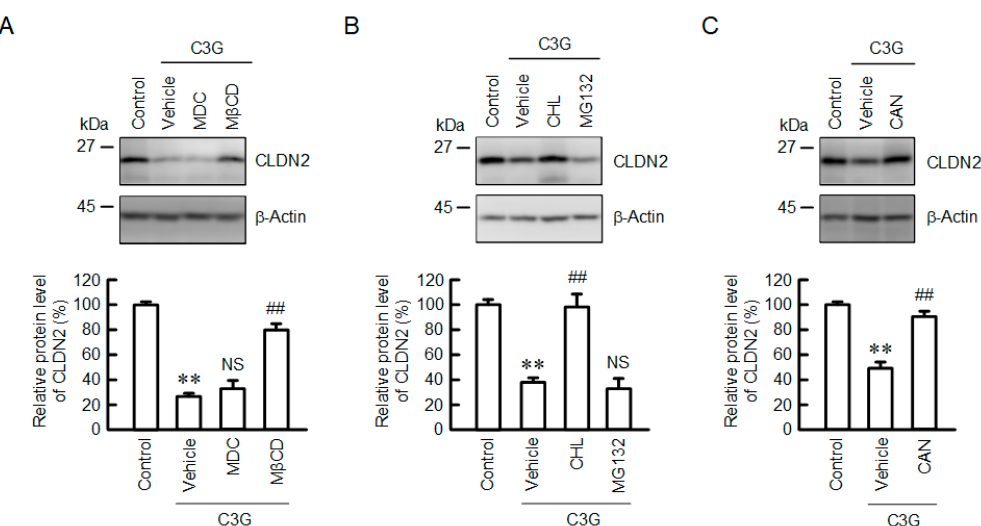
Figure 6. Effect of C3G on the degradation and endocytosis of the CLDN2 protein. ( A ) Cells were incubated in the absence (control) and presence of 50 µ M C3G, 5 µ M MDC, or 10 µ M M β CD for 24 h. ( B ) Cells were incubated in the absence (control) and presence of 50 µ M C3G, 20 µ M CHL, or 5 µ M MG132 for 24 h. ( C ) Cells were incubated in the absence (control) and presence of 50 µ M C3G for 24 h. CAN (0.5 µ M) was added into the medium 9 h before collection. Cell lysates were immunoblotted with anti-CLDN2 and anti- β -actin antibodies. The protein levels of CLDN2 are represented as a percentage relative to control. n = 3–5. ** p < 0.01 compared with control. ## p < 0.01, and NS p > 0.05 compared with